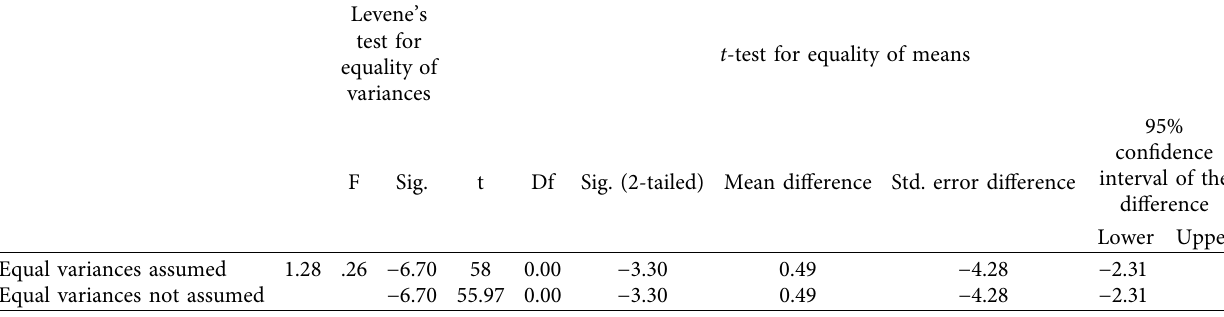
Table 14: Inferential statistics of the experimental and control groups in the speaking posttests.